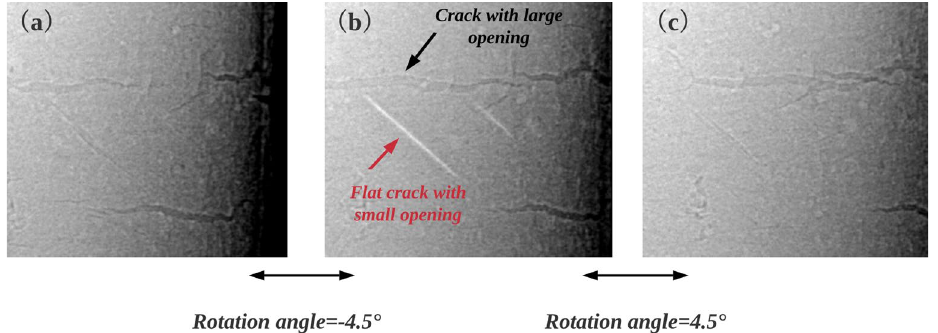
Figure 9. Experimental projections of one SRCT experiment (performed at ESRF and under same imaging conditions as in Fig. 1). ( a – c ): Three projections 4.5 ◦ apart. Internal flat cracks with small opening appear white on a limited number of projections (less than 10 ◦ range); Surface cracks with larger opening appear black with slight white fringes at their